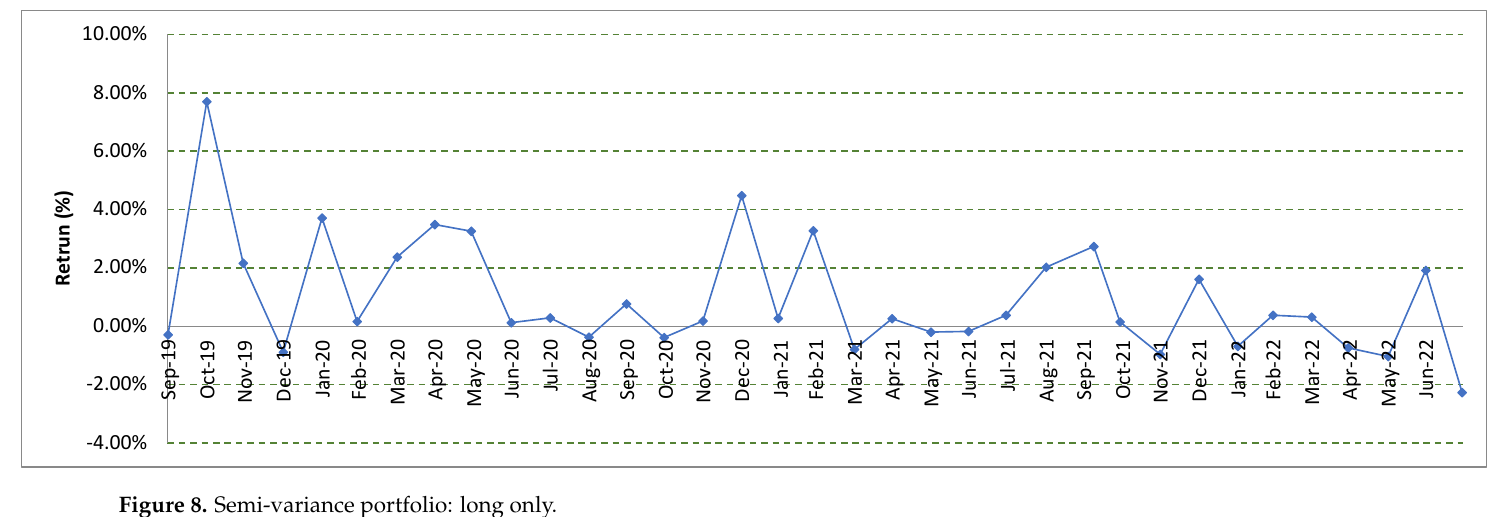
Figure 7. Utility maximizing portfolio ( A = 2): long-only.